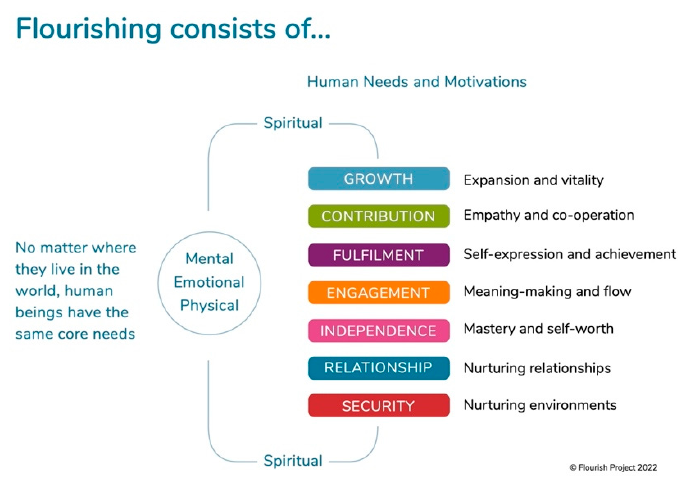
Figure 3. Flourish Project—The Seven Aspects extended.